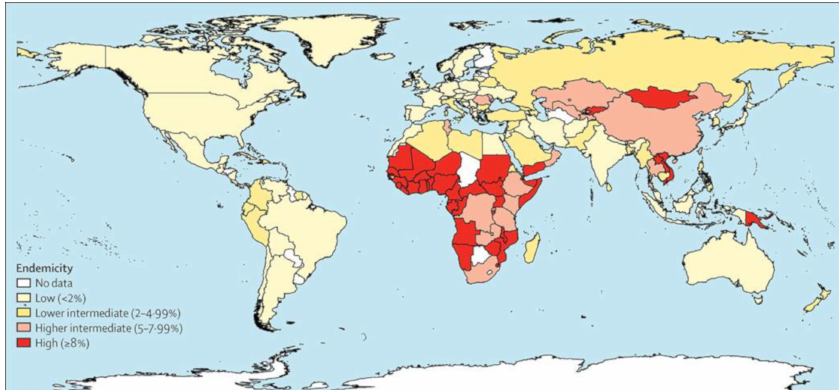
Figure 1. Regional prevalence of non-alcoholic fatty liver disease (NAFLD) diagnosed by radiological imaging (Pubmed and MEDLINE database from 1989 to 2015). Pooled prevalence was calculated by weighting the individual study estimates by inverse of their variation [11,20] (top panel). Global prevalence of chronic hepatitis B. Regional hepatitis B envelope antigen (HBeAg) prevalence estimates were produced from country-specific estimates. 95% CI were obtained from country-specific variances of the prevalence estimates from logistic regression model (bottom panel). Copyright permission taken from